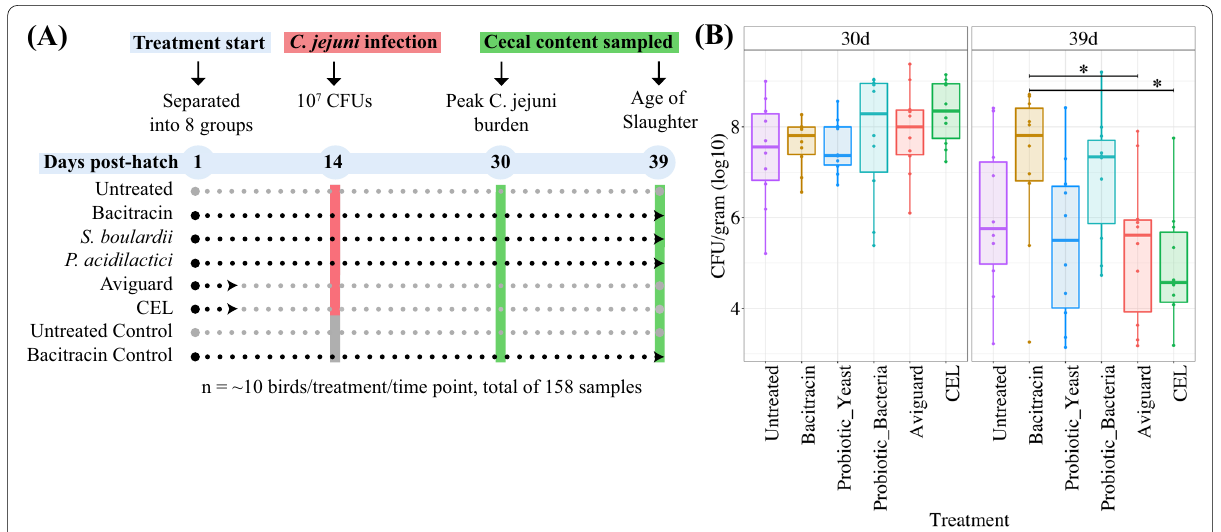
Fig. 1 Schematic of Experimental Design and C. jejuni burden. A Experimental design. Chickens were divided randomly into 8 groups and assigned to either one of 6 treatments or left untreated at day one of age (Aviguard, CEL, probiotic bacteria ( Pediococcus acidilactici CNCMI-4622 ), probiotic yeast ( Saccharomyces cerevisiae boulardii CNCMI-1079 ), AGP (bacitracin)). On day 14, all groups, except for two (one bacitracin and one untreated group) were orally challenged with 10 7 CFUs of C. jejuni (strain 81–176). Samples of cecal contents were collected at day 30 and 39 of age (n birds per time point and treatment group, total of 158 samples for CFU enumeration and 16S rRNA sequencing). After sample collection, tenfold serial dilutions in PBS were plated onto Muller Himton agar containing Preston Campylobacter Selective Supplement. Plates were incubated in microaerophilic conditions at 41 °C and CFUs of C. jejuni were enumerated after 40–48 h and expressed as log 10 Campylobacter /g of cecal content. B Boxplots representing the median of CFUs of C. jejuni in each treatment group. Statistical analysis was performed using Kruskal–Wallis test followed by pairwise Dunn’s tests. * P <